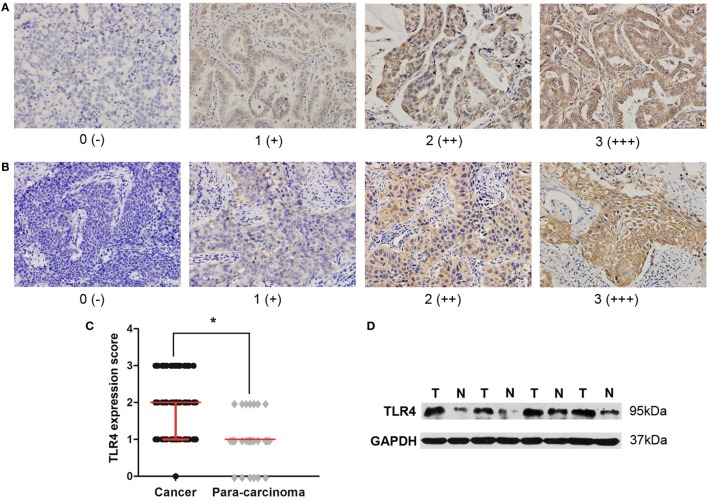
High expression level of toll-like receptor 4 (TLR4) in non-small cell lung cancer (NSCLC) tissues. (A) Typical immunohistochemical staining of TLR4 in lung adenocarcinoma. Scores 0, 1, 2, and 3 represent negative (−), weak positive (+), moderate positive (++), and strong positive (+++) expression, respectively. (B) Typical immunohistochemical staining of TLR4 in lung squamous cell carcinoma. Scores 0, 1, 2, and 3 represent negative (−), weak positive (+), moderate positive (++), and strong positive (+++) expression, respectively. (C) Comparison of TLR4 expression level between cancer tissue and para-cancer tissue in 60 patients with NSCLC. TLR4 was expressed at a significantly higher level in cancer cells than in corresponding para-carcinoma cells, as the result of Wilcoxon rank sum test. *P < 0.05. (D) Western blotting analysis was further performed to confirm the lower expression of TLR4 in four matched normal tissues (N) compared with tumor tissues (T).